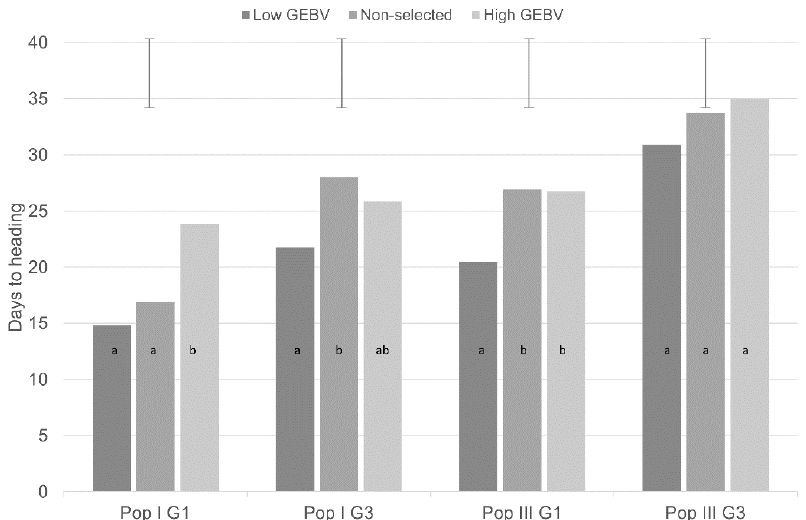
Figure 2. Days-to-heading for Low genomic estimated breeding value (GEBV), High GEBV, and Non-selected selection group (SG) progeny samples ( n = 25 per SG) generated by genomic selection from four populations (Pop I G1, Pop I G3, Pop III G1, and Pop III G3). Data are best linear unbiased estimates (BLUEs) across two seasons and two locations (Waikato and Manawatu, New Zealand). Within each population, SG bars with different letters are significantly different ( p < 0.05), as supported by least significant difference (L.S.D 0.05 ) error bars.